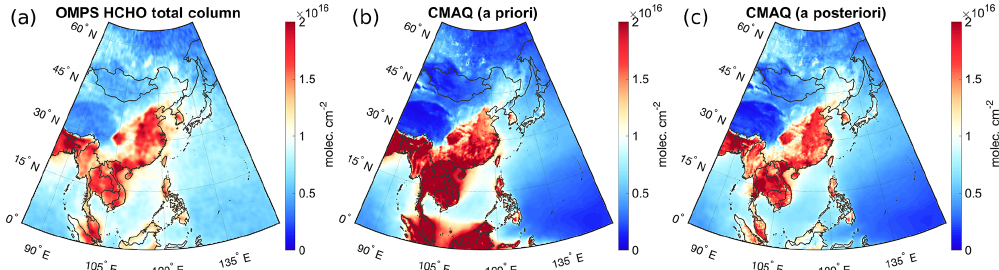
Figure 7. (a–c) HCHO total columns from OMPS, the WRF-CMAQ simulated with the prior emissions, and the same model but with the top-down emissions constrained by the satellites in May–June 2016.